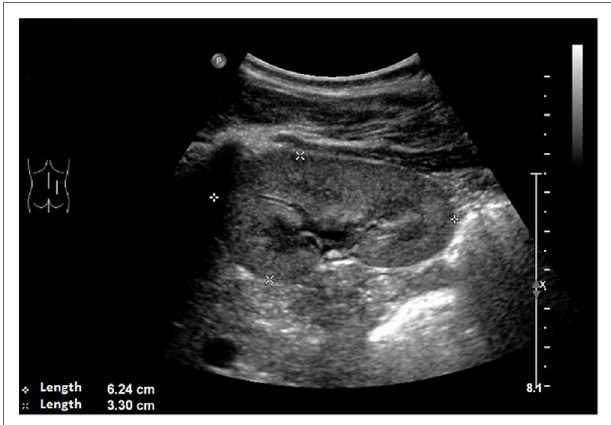
FIgURe 3 | Ultrasound of the right kidney with a length of 6.2 cm ( < 1st